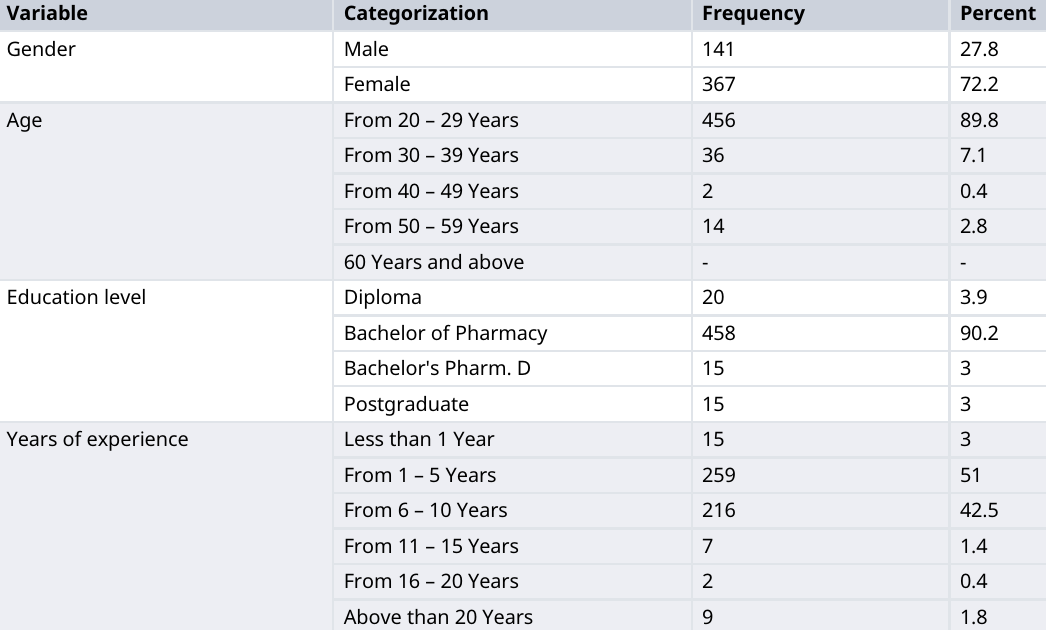
Table 1. Socio-demographic characteristics of